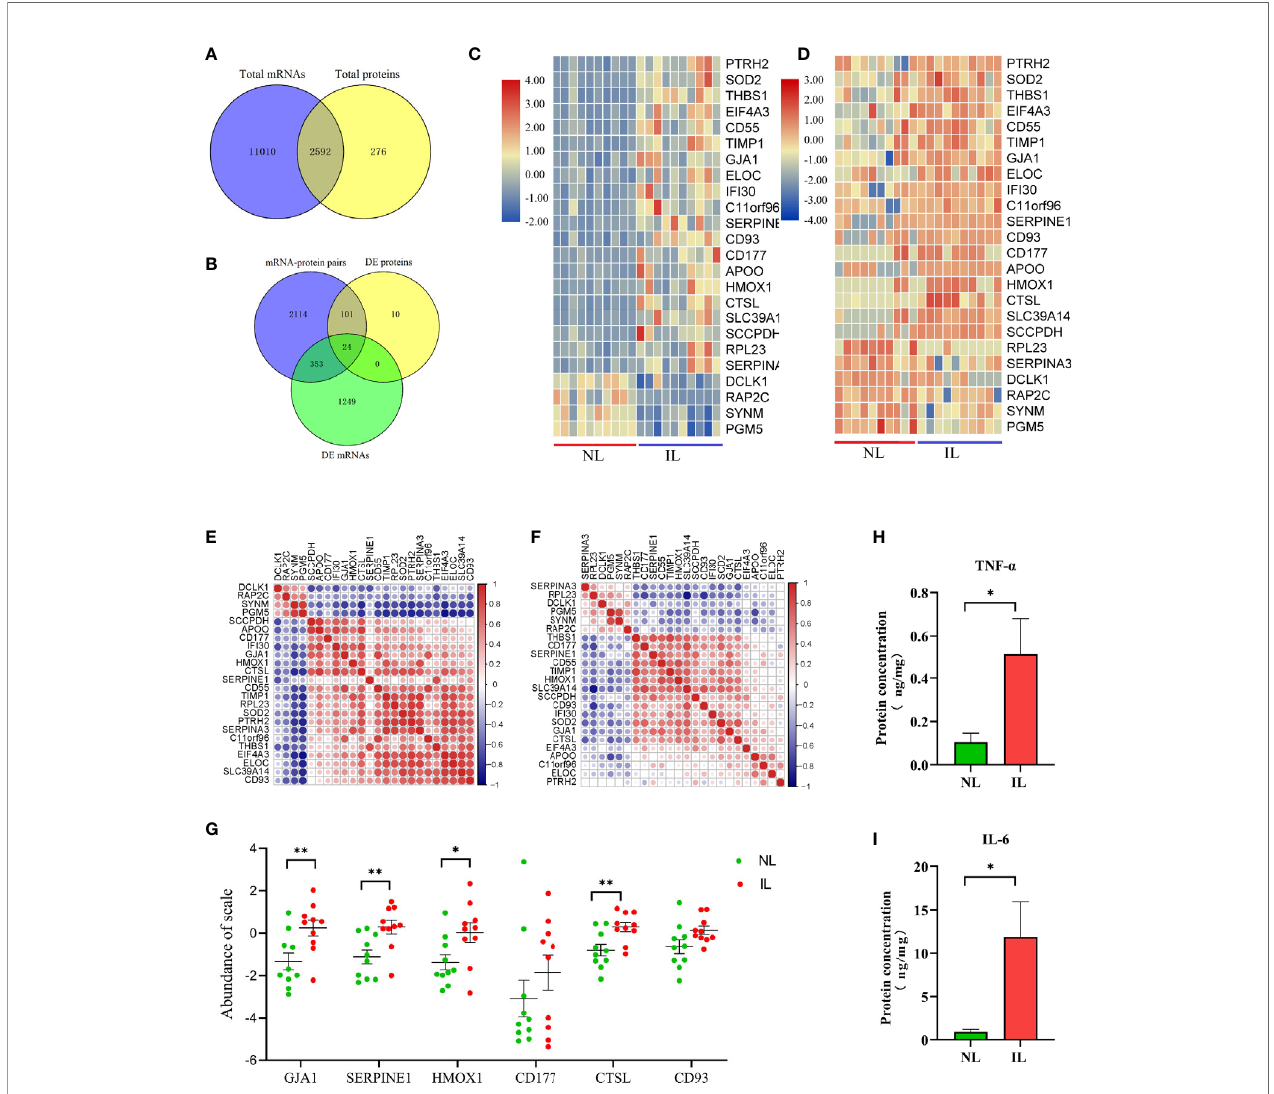
FIGURE 3 | Visualization of the proteotranscriptomic results between nonlabor and in labor myometrium. (A) Venn diagram of the gene set identi fi ed both in transcriptome and proteome. (B) Venn diagram of gene sets of mRNA – protein pairs, DE mRNAs, and DE proteins. (C, D) Heatmaps of expression of the 24 overlapping mRNAs (C) and proteins (D) . The color gradient represents gene expression levels as z-scores. (E, F) Correlation matrix of the expression levels of the 24 overlapping mRNAs (E) and proteins (F) . The darker the dot, the stronger the correlation. Red indicates positive correlation; blue indicates negative correlation. (G) Quanti fi cation validation of proteins by PRM. (H, I) Quanti fi cation validation of TNF- a and IL-6 by Luminex assays. *p<0.05,